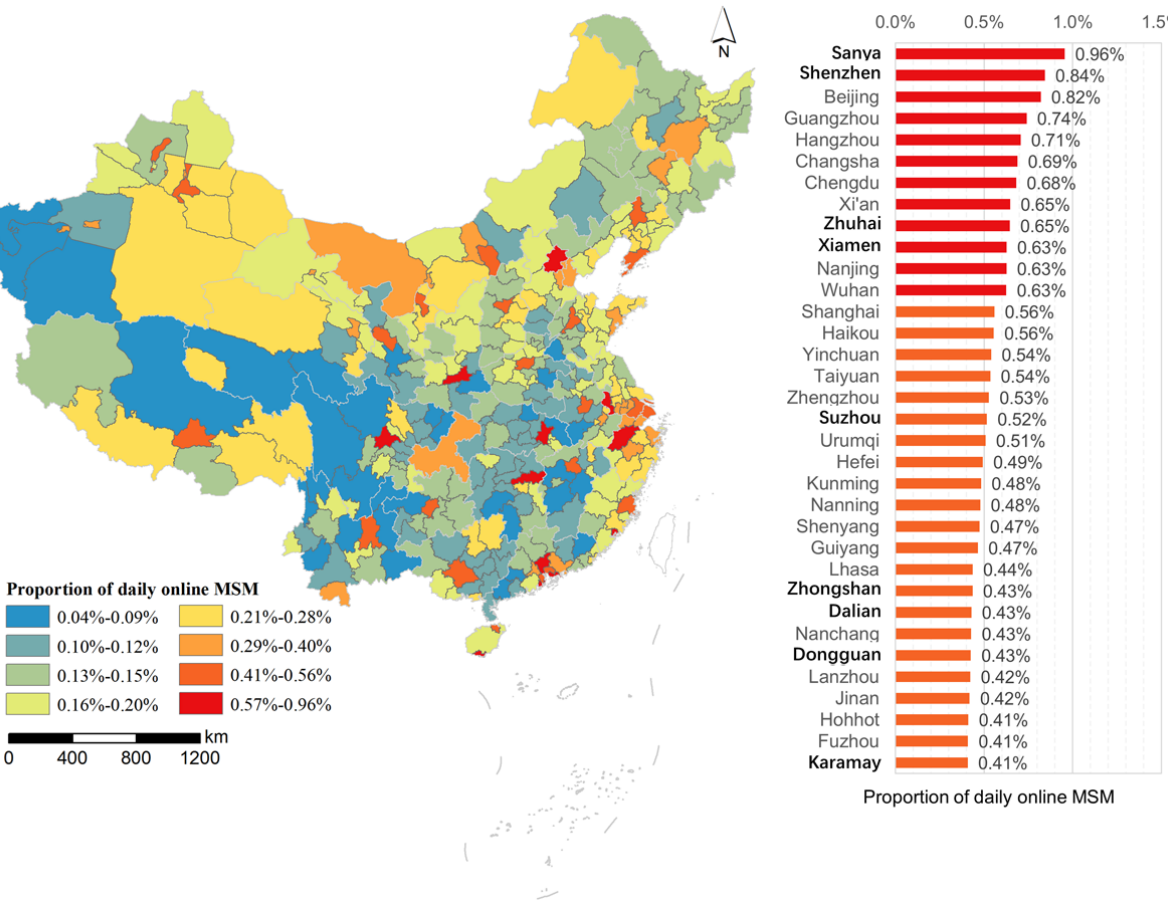
Figure 4. City-level distribution of the proportion of daily online MSM from nonholiday social networking. Cities in bold type are nonprovincial